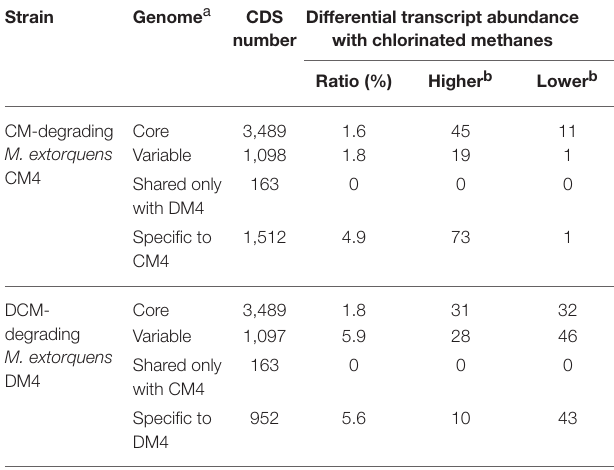
TABLE 2 | Differential expression of core, variable, shared and strain-specific CDS during growth with chlorinated methanes.